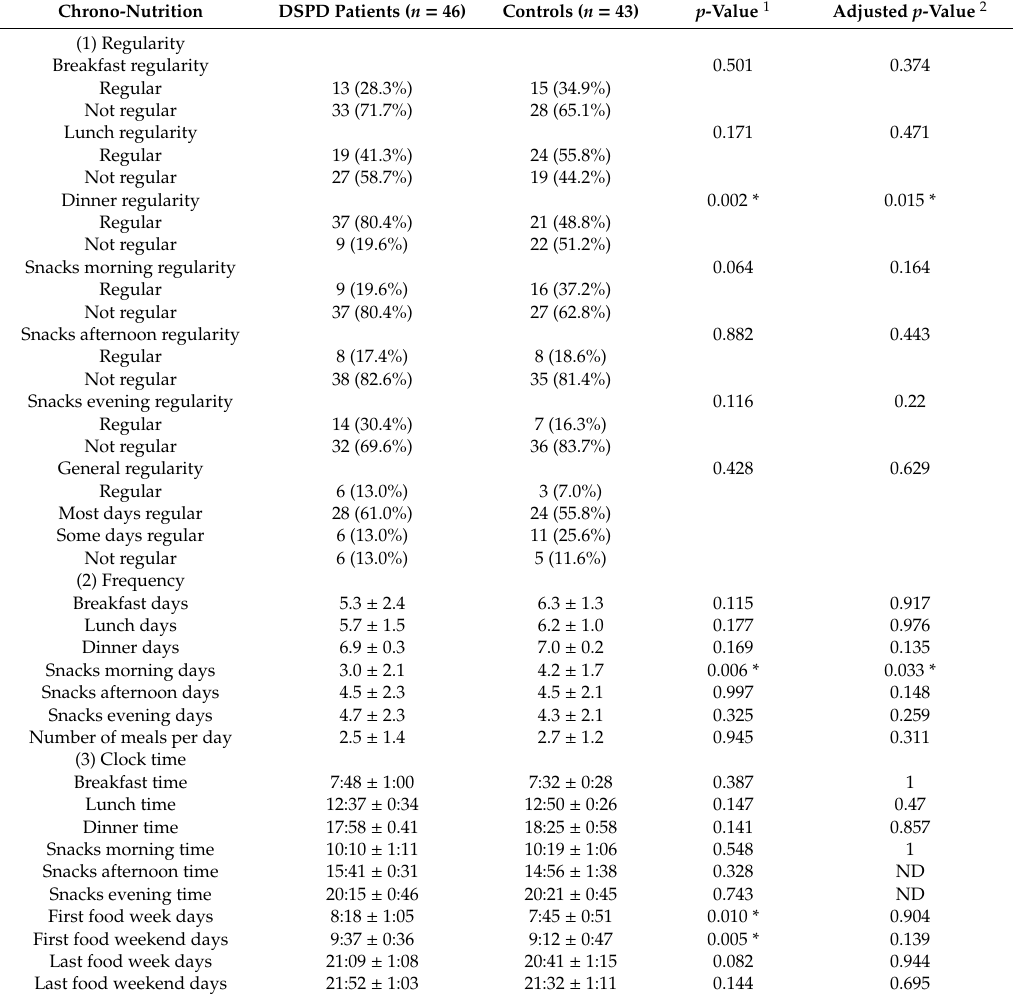
Table 2. Chrono-nutrition in DSPD patients compared with controls. Values are presented as mean ± SD or n